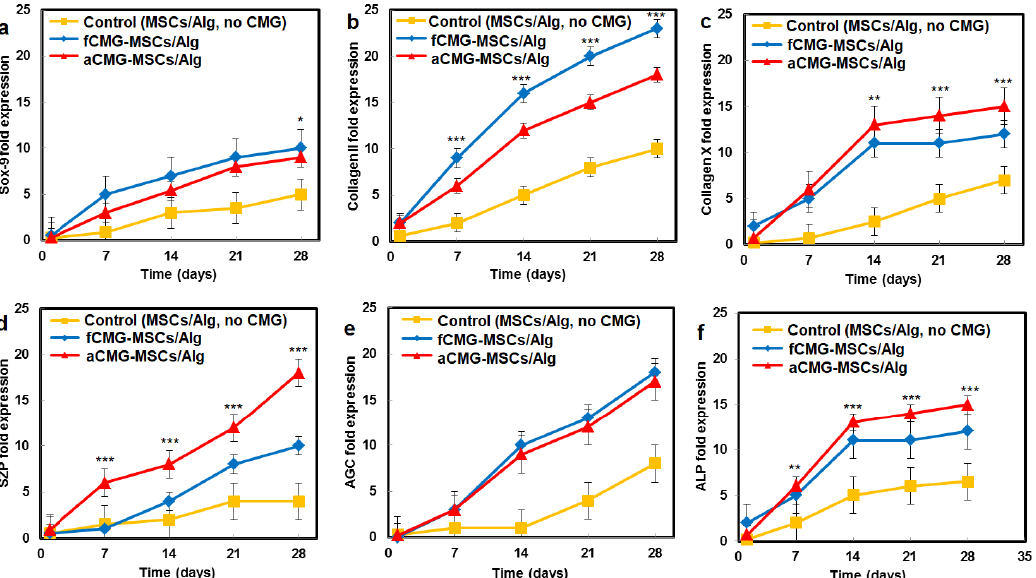
Figure 6. The mRNA expression of chondrogenic markers ( a ) Sox-9, ( b ) Col II, ( c ) Col X, ( d ) SZP, ( e ) AGC, and ( f ) ALP with incubation time for fCMG-MSCs (blue) and aCMG-MSCs (red) encapsulated in alginate hydrogels and cultured in chondrogenic medium for 28 days; the control group (yellow) was hMSCs (without CMGs) encapsulated in the alginate hydrogel and cultured in chondrogenic medium. The average size of CMGs of the hydrogel constructs for mRNA expression studies was 190 µm; one asterisk (*), two asterisks (**), and three asterisks (***) indicate a statistically significant dif-ference between two experimental groups at a given time point at the levels of p < 0.05, p < 0.01, and p < 0.001, respectively. The compressive modulus of aCMG-MSCs/Alg and fCMG-MSCs/Alg hydrogels was measured as a function of CMG loading with culture time in chondrogenic medium, and the results are shown in Figure 7a – c and 7d – f, respectively. The hMSCs encapsulated di- rectly in the alginate hydrogel and cultured in chondrogenic medium were used as the control. For all adult and fetal CMG-MSCs/Alg hydrogel constructs, the modulus in- creased continuously with culture time. For any culture time, the modulus of adult and fetal CMG-MSCs/Alg constructs was higher than that of the control group (yellow curve) for all CMG loadings and sizes. The moduli of adult and fetal CMG-MSCs/Alg hydrogels with CMG loadings of 50% and 70% were higher than that with 30% CMG loading for all CMG sizes and incubation times. The moduli of adult and fetal CMG-MSCs/Alg hydro- gels with CMG sizes of 190 and 250 μm were higher than that with 90 μm CMG size for all CMG loadings and culture times. For adult cartilage microgels, the CMG-MSCs/Alg hydrogel with 250 μm size and 50% CMG loading had highest modulus of 23 8 ± 10 kPa after eight weeks of incubation. For fetal cartilage microgels, the CMG-MSCs/Alg hydro- gels with 250 or 1 90 μm size and 50% CMG loading had the highest modulus at 197 ± 20 kPa after eight weeks of incubation. Overall, the adult CMG-MSCs/Alg hydrogel with 250 μm size and 50% CMG loading had the highest modulus. As the extent of chondrogenic differentiation of hMSCs has been shown to increase with increasing cell – cell contact [29], the higher modulus of adult or fetal CMG-MSCs/Alg hydrogels with CMG sizes of 250 and 190 μm was attributed to the higher cell density per CMG, which increased cell – cell interaction and chondrogenesis.